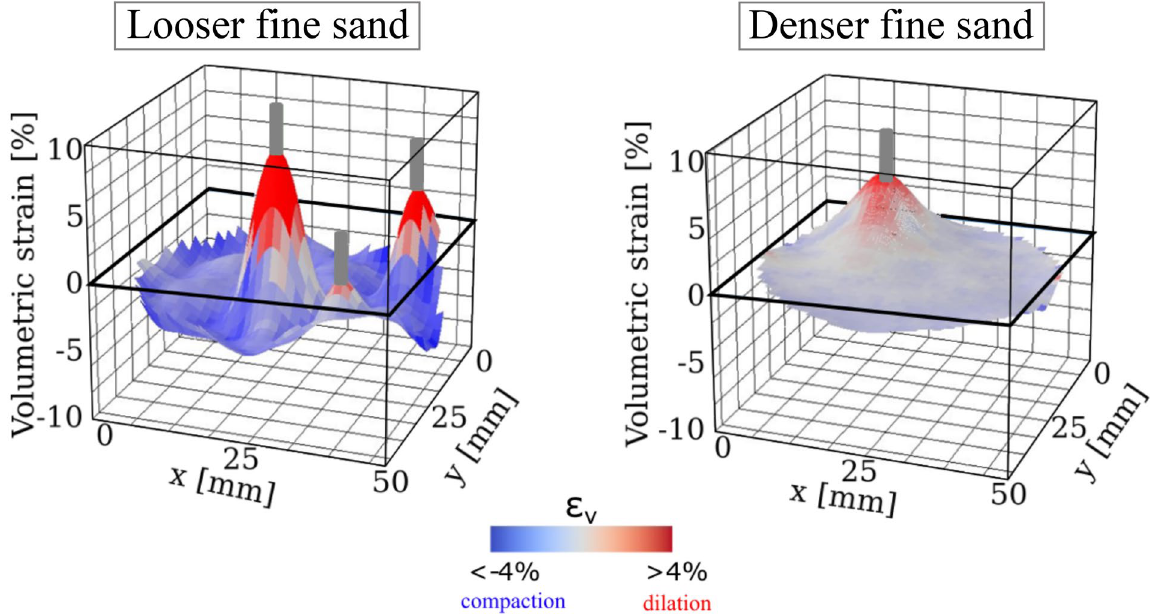
Figure 8. 3D surface plots of volumetric strain in the vicinity of the root axis in looser (left) and denser (right) sand. The data correspond to the root system at Day 3 at depth of 37.7–39 mm. The soil experiences dilation (red) close to the root for both densities. The soil experiences compaction further from the root for the looser sand only.